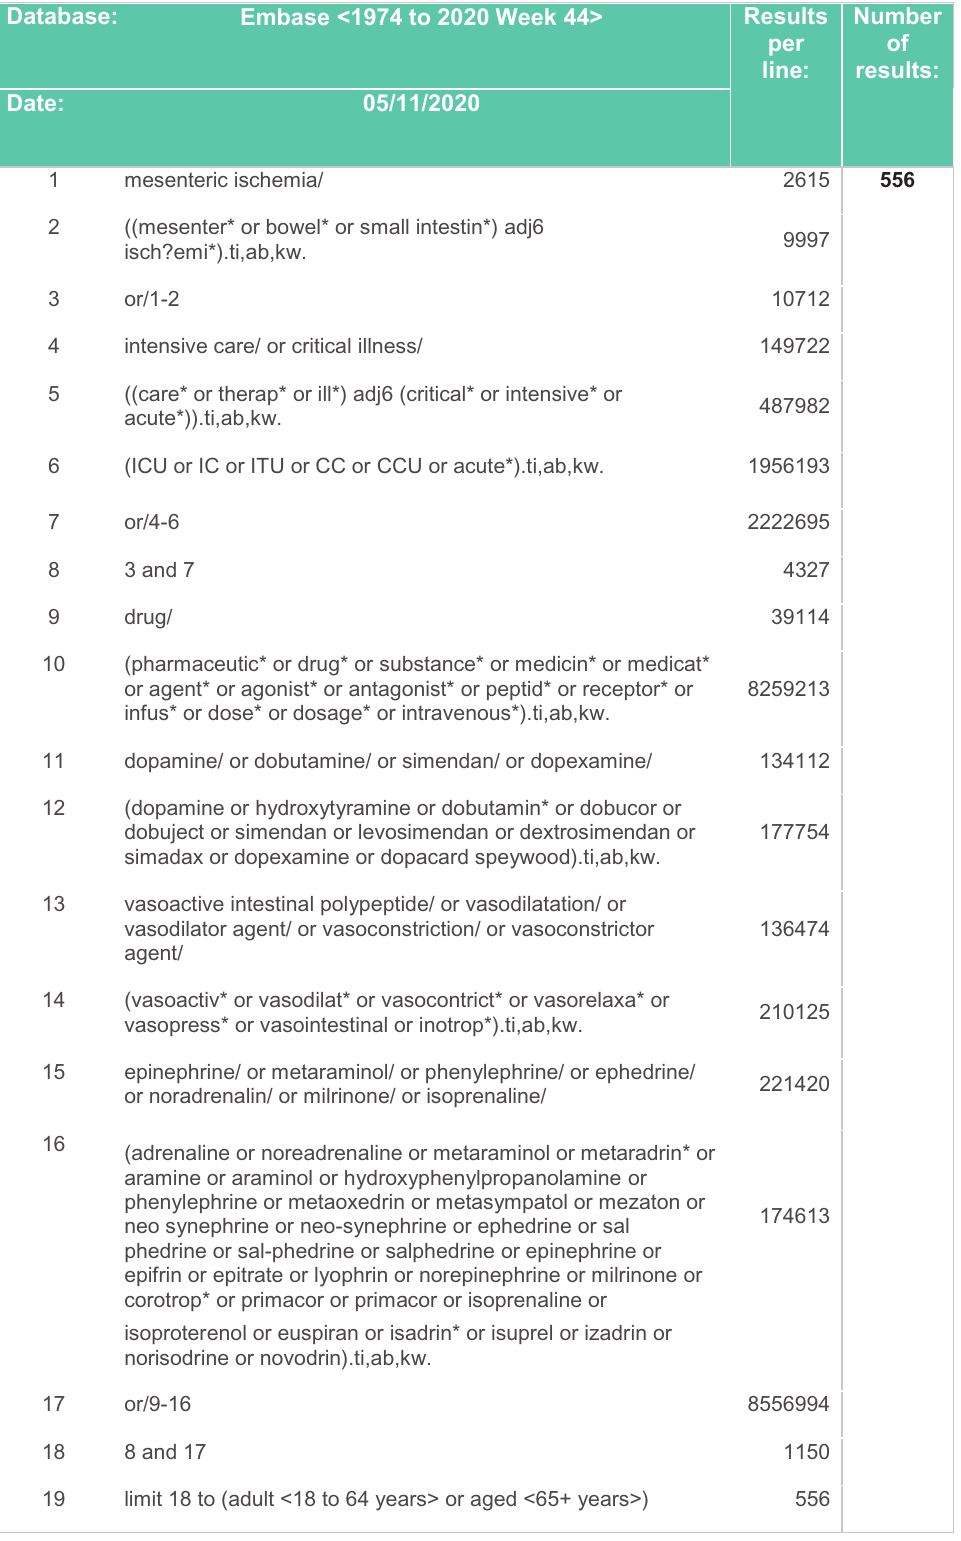
Figure 3. Search strategy –